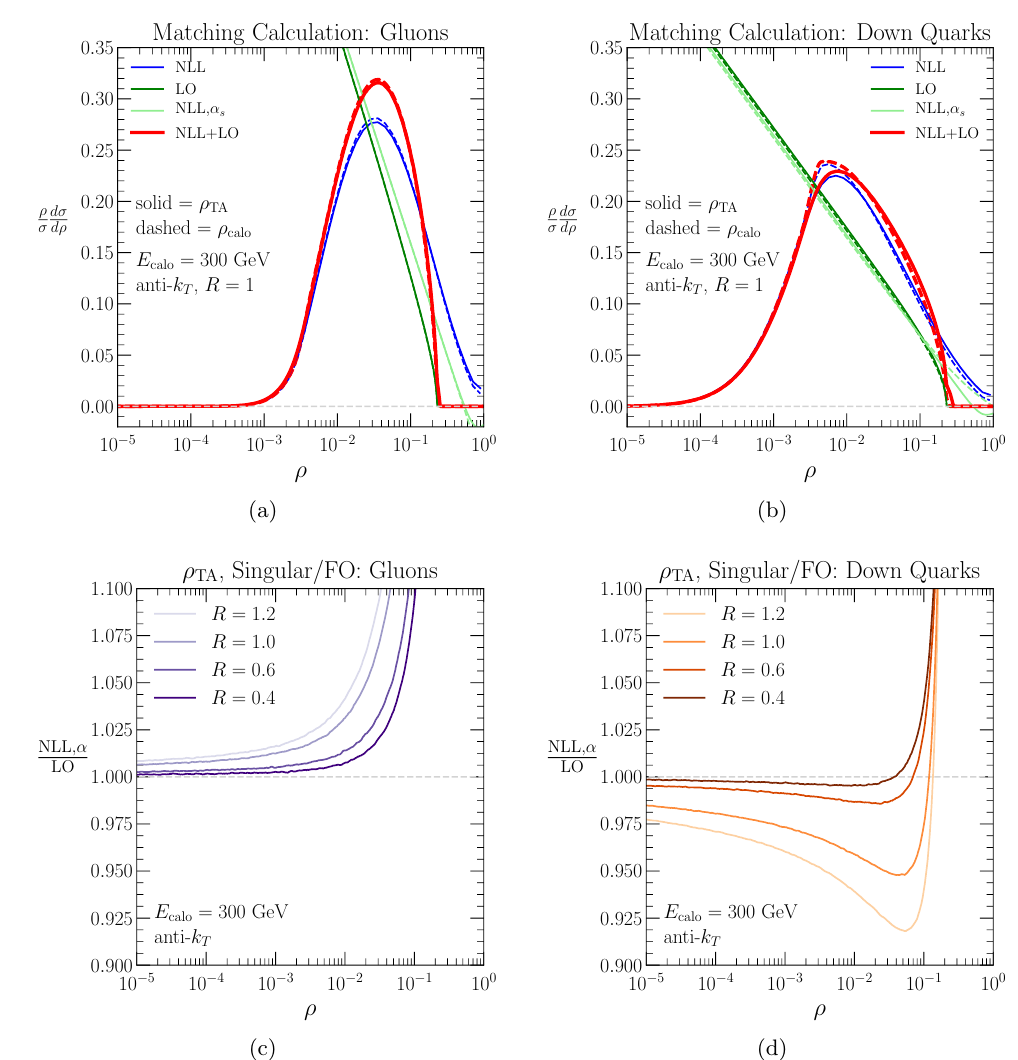
Figure 10 . Top row: components of the matching calculation for (a) gluons and (b) down quarks. The full matched NLL+LO result is in red, the LO (cid:12)xed-order distribution is in dark green, and the ( (cid:11) s ) piece of the (cid:12)xed-order expansion of the NLL resummed distribution is in light green. O The NLL distribution is plotted in blue. Bottom row: the corresponding ratios of the of the NLL distribution over the LO di(cid:11)erential distribution, for various values of jet radius R to highlight the R log R